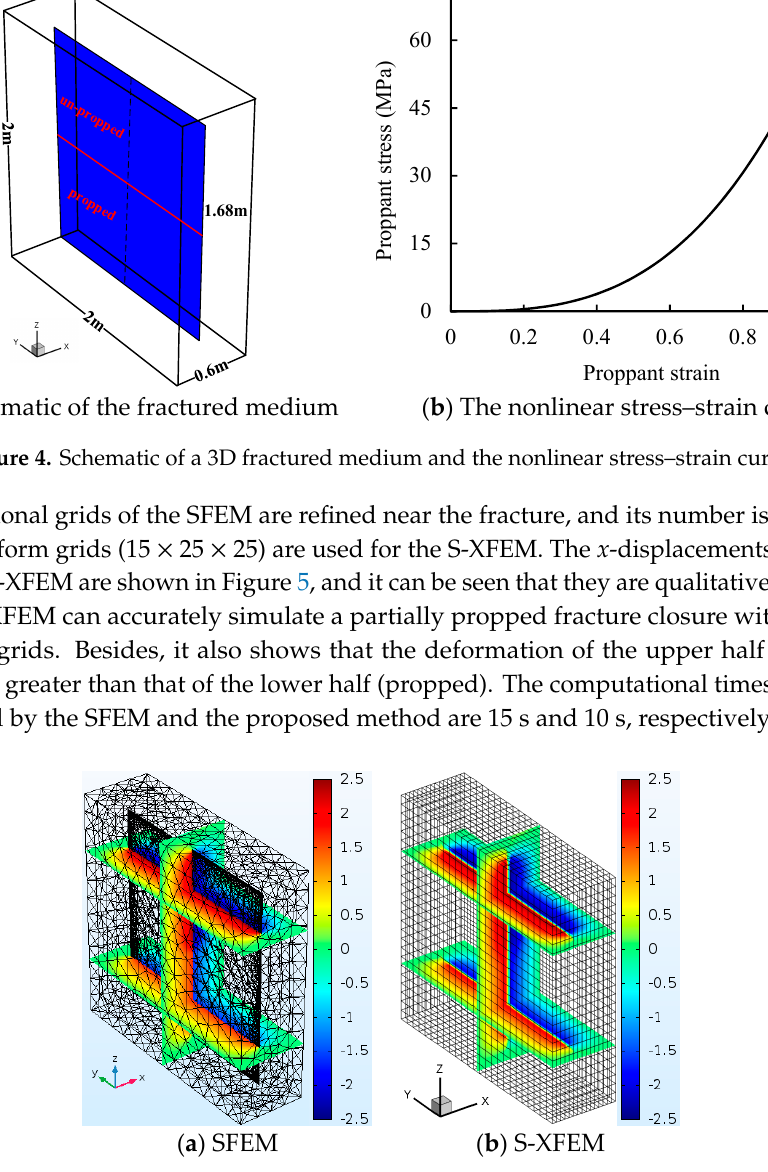
Figure 5. Comparison of x -displacement obtained from two different methods, mm.